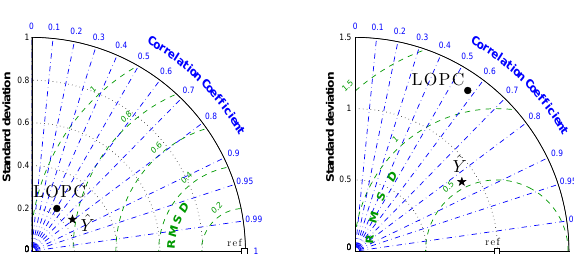
Figure 5. Taylor diagram (Taylor, 2001) of the correlation (R), the centered root mean square difference (RMSD) and standard devi- ation (STD) between NBSS parameters ( a : slope and b : intercept) estimated by the WP2/Zs and estimated by the LOPC (black plain circles) and after the PLS (partial least square) regression performed on the LOPC ( ˆ Y , black plain stars). The white square indicates the maximum ( R = 1, RMSD = 0 and STD =